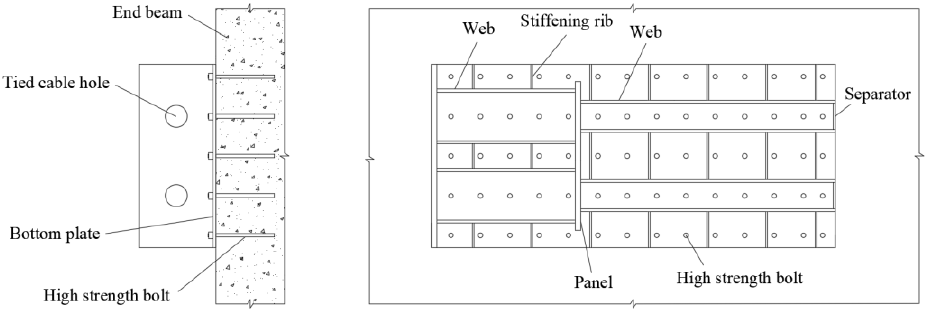
Figure 12. Design of the steel anchor box.